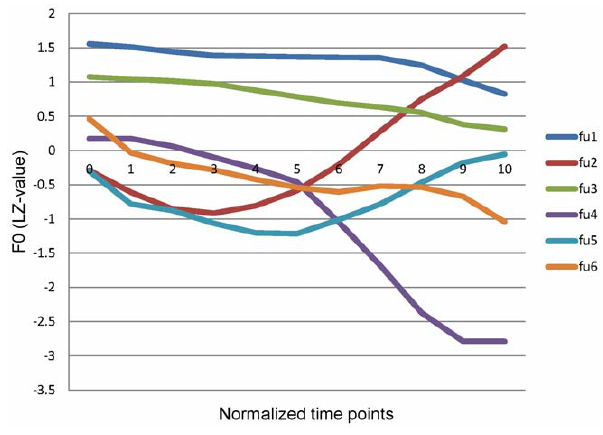
Figure 1. Pitch contours of time-normalized syllable fu in